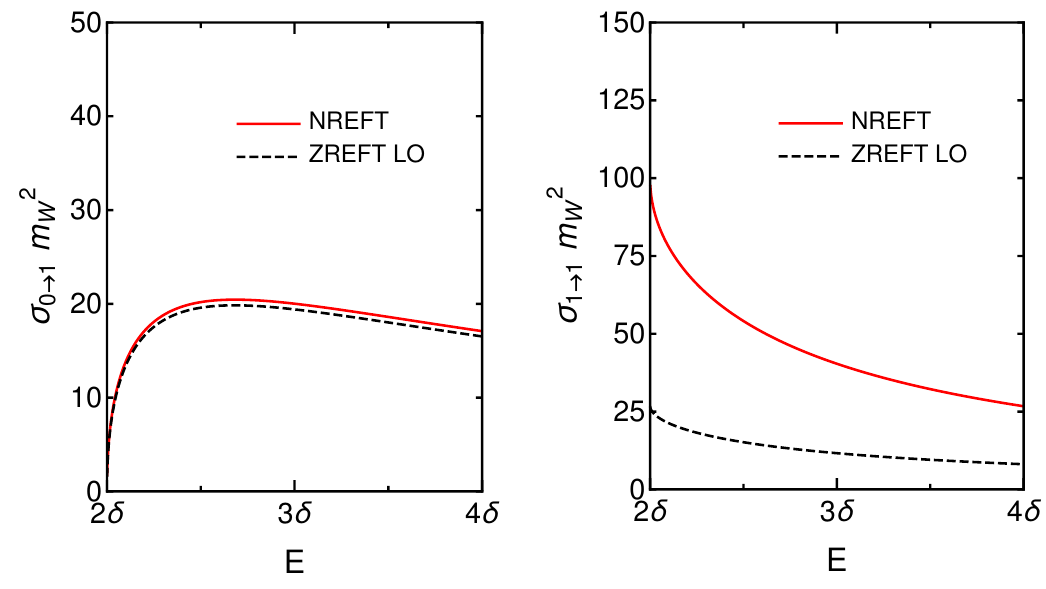
Figure 13 . The neutral-to-charged transition cross section (cid:27) 0 ! 1 (left panel) and the charged-wino elastic cross section (cid:27) 1 ! 1 (right panel) as functions of the energy E . The cross sections for (cid:11) = 0 at the unitarity mass M (cid:3) = 2 : 88 TeV are shown for NREFT (solid line) and for ZREFT at LO (dashed